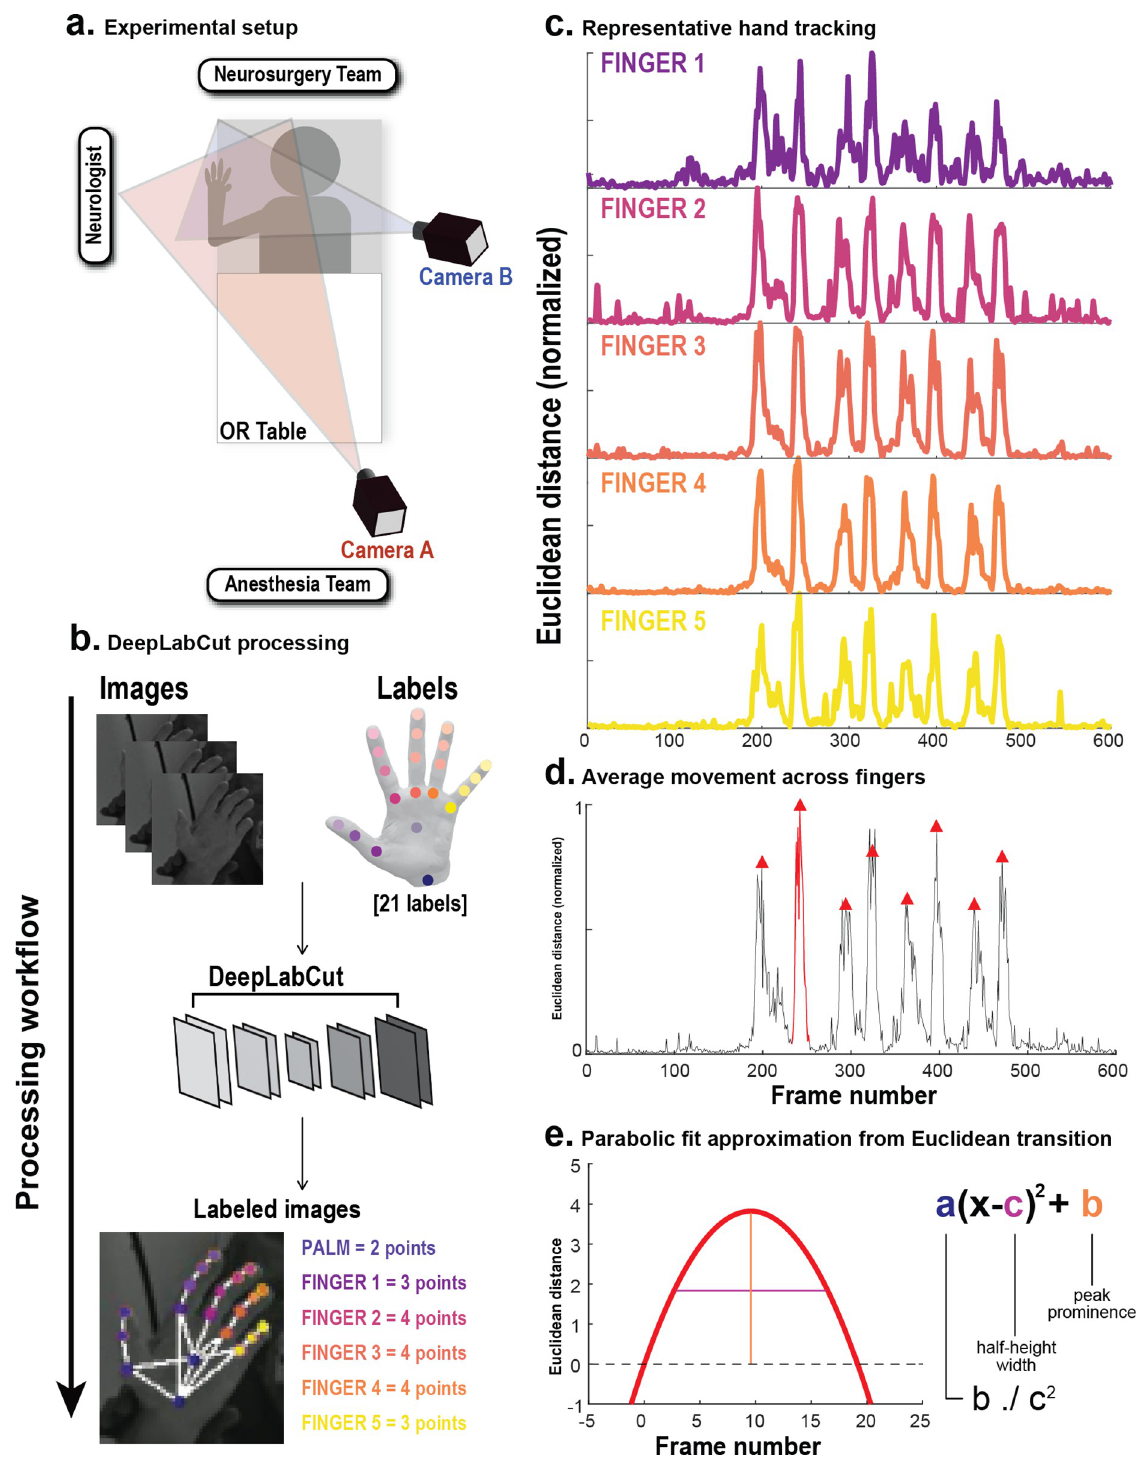
Fig 1. Processing workflow from DLC and post-hoc data analysis. (A) Setup of the two-camera recording system, highlighting all members of a typical neurosurgical team. (B) Simplified neural network consisting of inputted videos and labels. (C) Consolidation and smoothing of label trajectories into five groups, displayed on a normalized plot. Hand clench sample shown. (D) MATLAB’S findpeaks function employed to identify movement epochs. Half-height width and peak prominence extracted for each epoch. (E) Each epoch is fitted to a parabolic function with coefficients a, b, c to be added to the pipeline for movement type